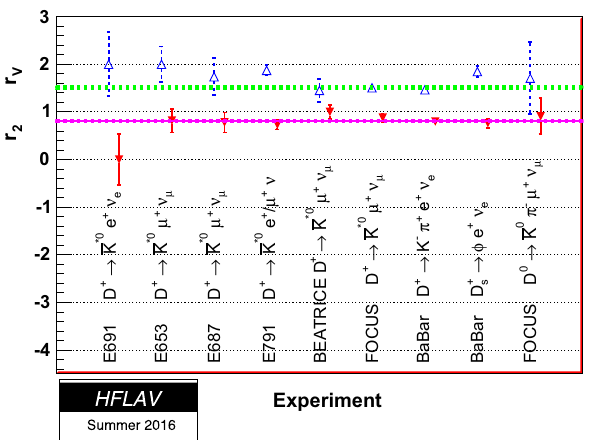
Fig. 204 A comparison of r 2 ( filled inverted triangles ) and r V ( open triangles ) values from various experiments. The first seven measure- ments are for D + → K − π + l + ν l decays. Also shown as a line with 1- σ limits is the average of these. The last two points are D + s and D 0 decays